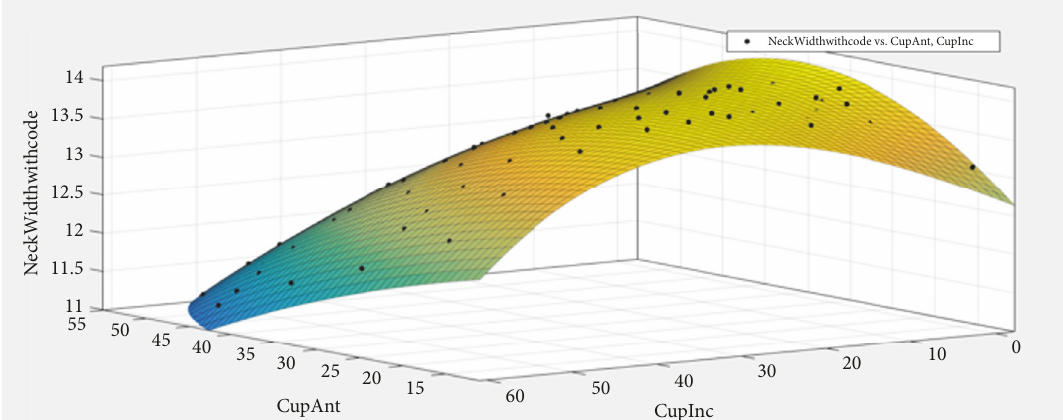
Figure 2: Surface interpolation of stem neck width.